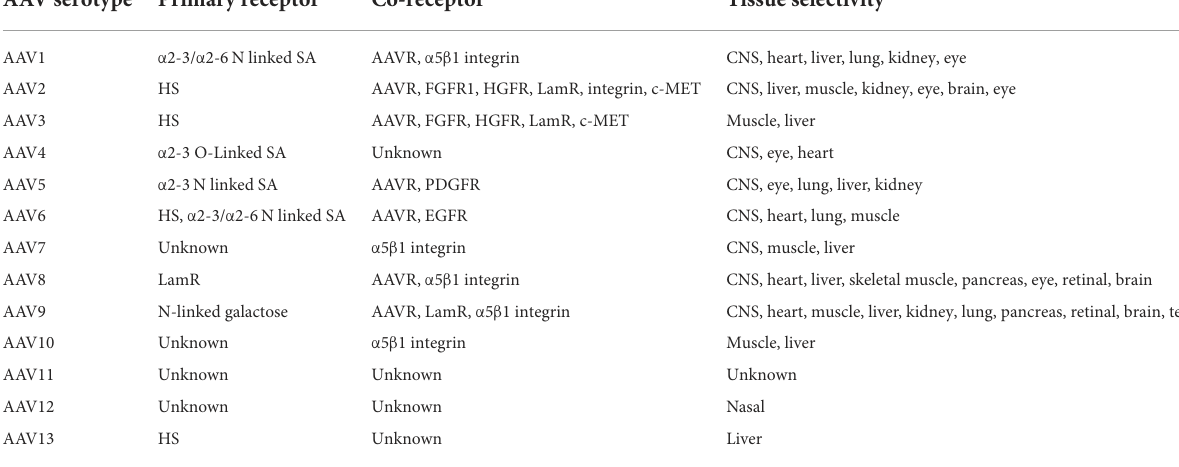
TABLE 1 Receptor and tissue selectivity of AAV serotypes (4,